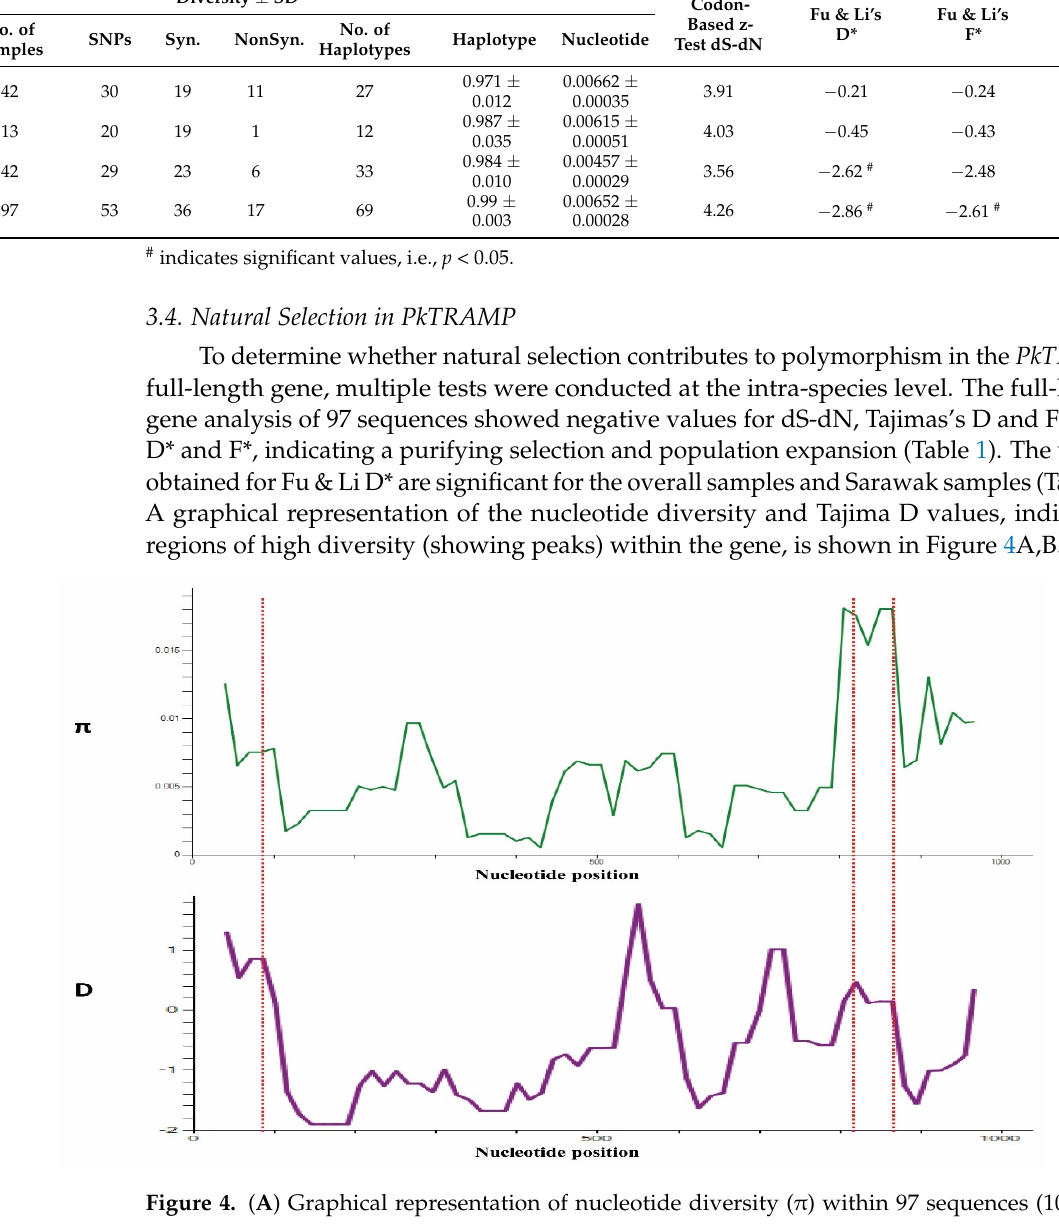
Figure 4. ( A ) Graphical representation of nucleotide diversity ( π ) within 97 sequences (1001 bp) of PkTRAMP gene from Malaysian clinical isolates. The probable epitopes are marked with a star symbol. ( B ) Graphical representation of Tajiam’s D value across the PkTRAMP gene. Red dotted lines are used to indicate the peaks in the ( π ) graph and D graph.